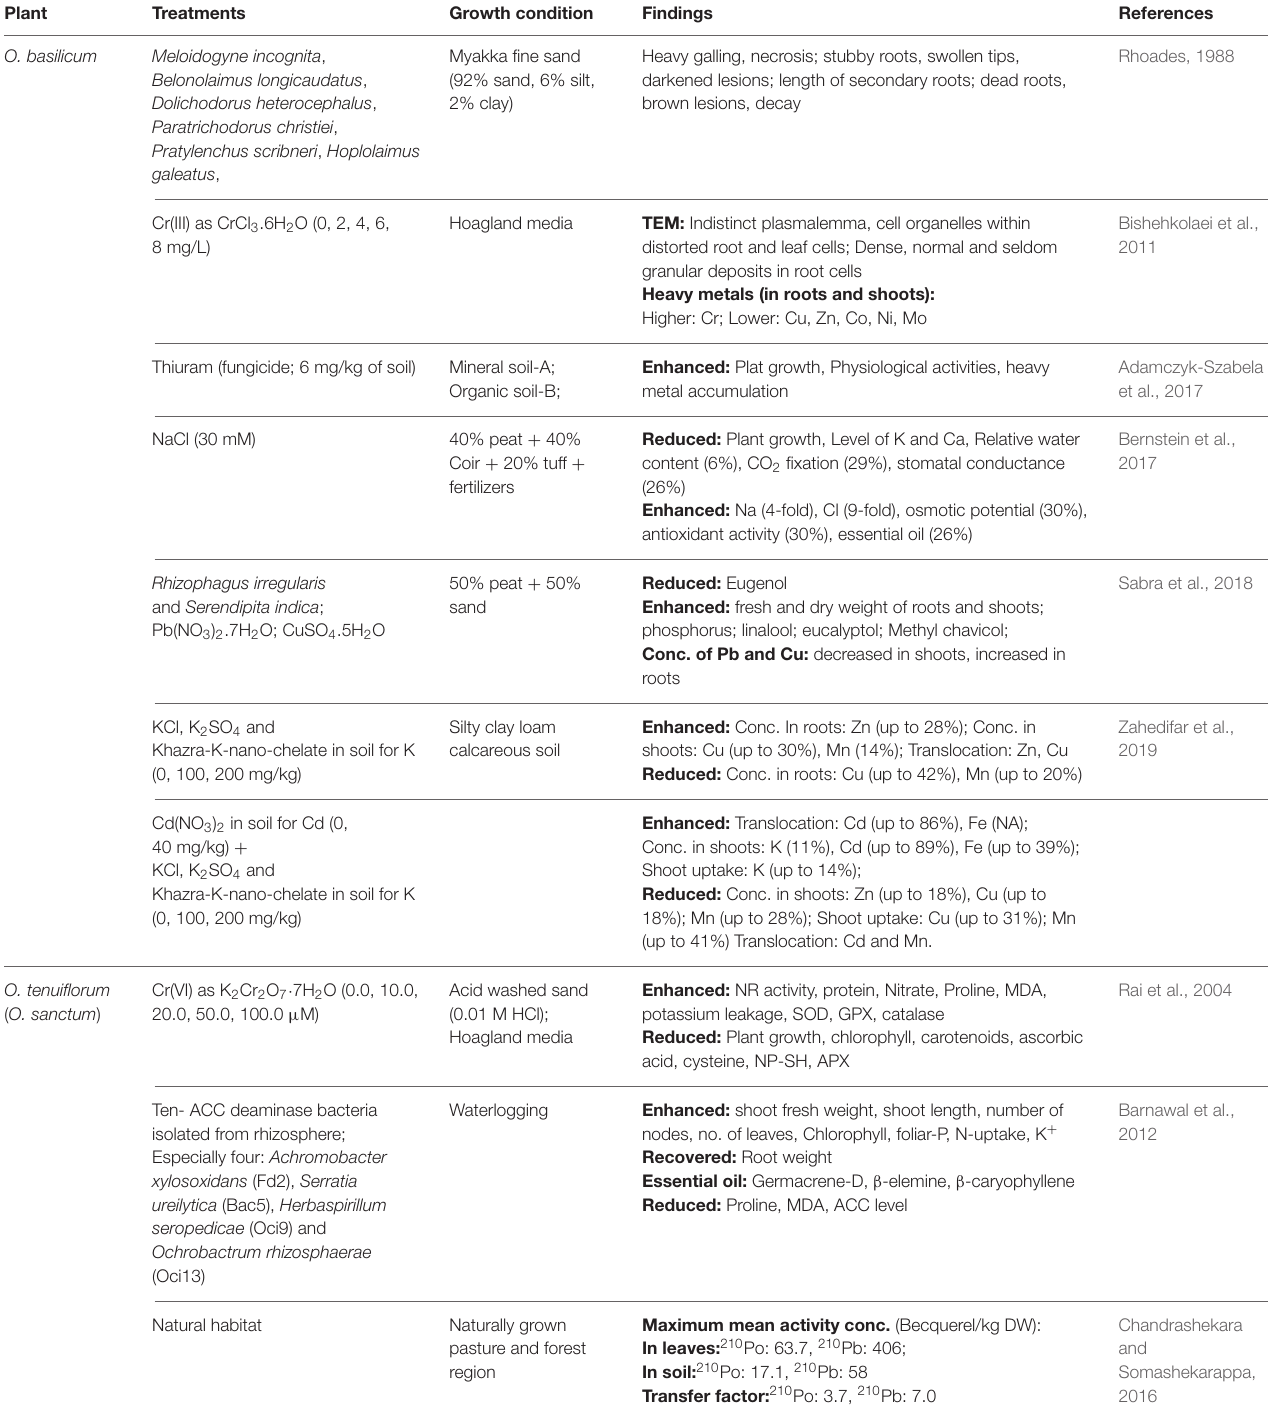
TABLE 2 | Effect of microorganisms (nematode, deaminase bacteria, and symbiotic fungi) and different abiotic stresses (salt heavy metal and radioactive metal) on roots and the whole plant of Ocimum sp. Plant